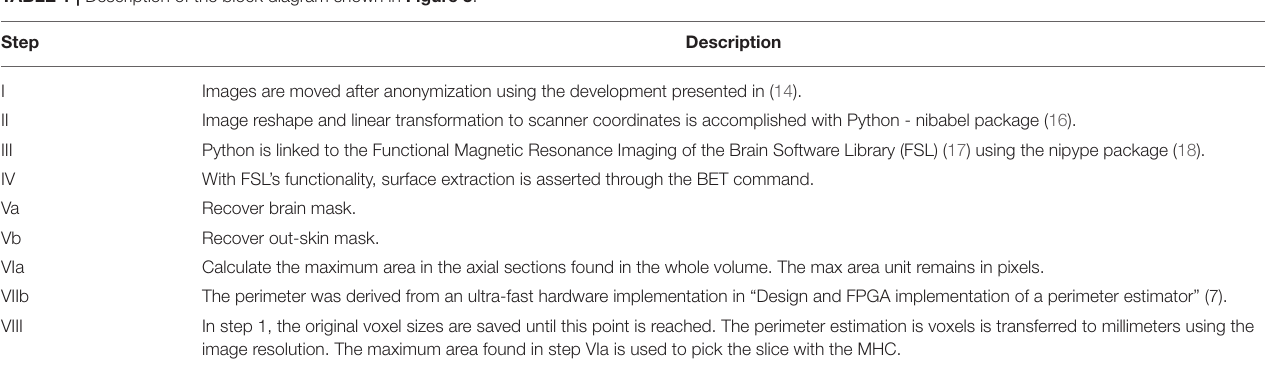
TABLE 1 | Description of the block diagram shown in Figure 3 .